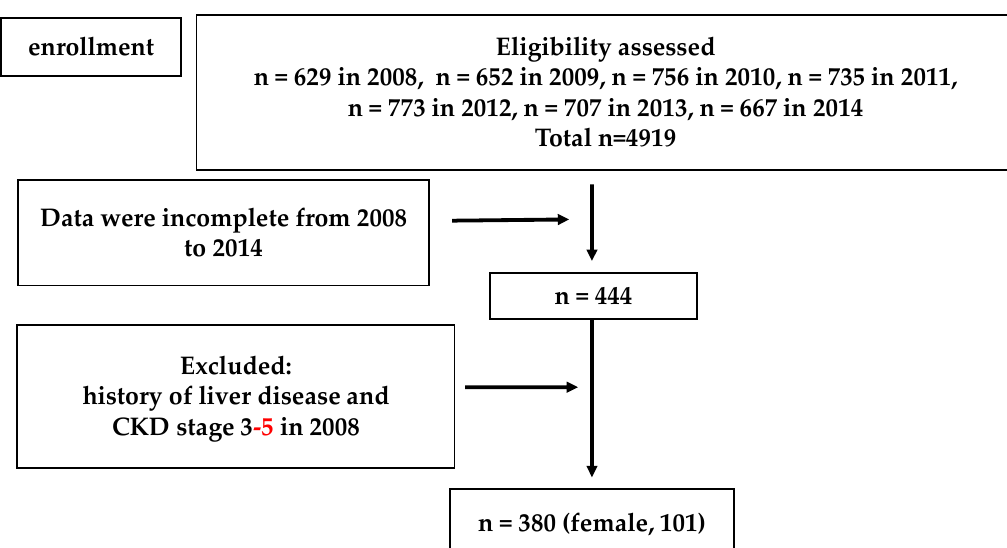
Figure 2. Flow chart of the Study 2 population selection.